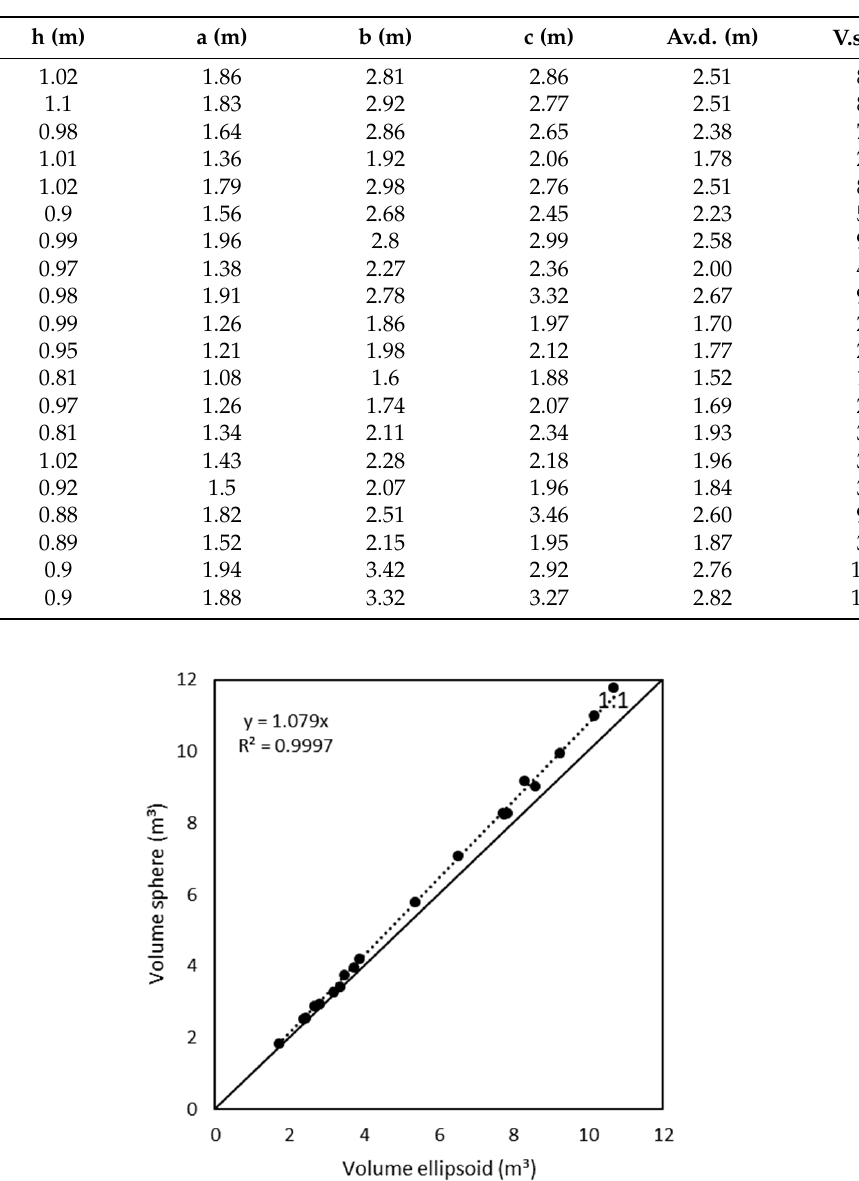
Table 2. Ground-truth values. h: distance from the canopy to the ground; a: height; b: length; c: width;